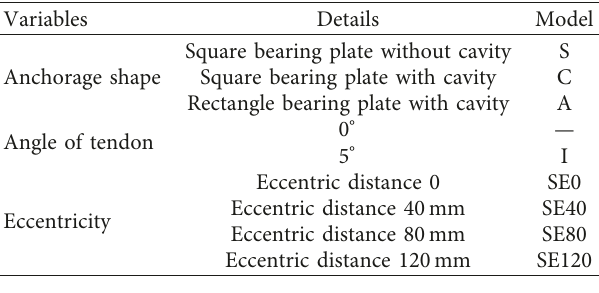
Figure 7: Variables for the finite element analysis model. (a) Anchorage shape. (b) Angle of the tendon. (c) Eccentric Table 2: Parameters for the finite element analysis.